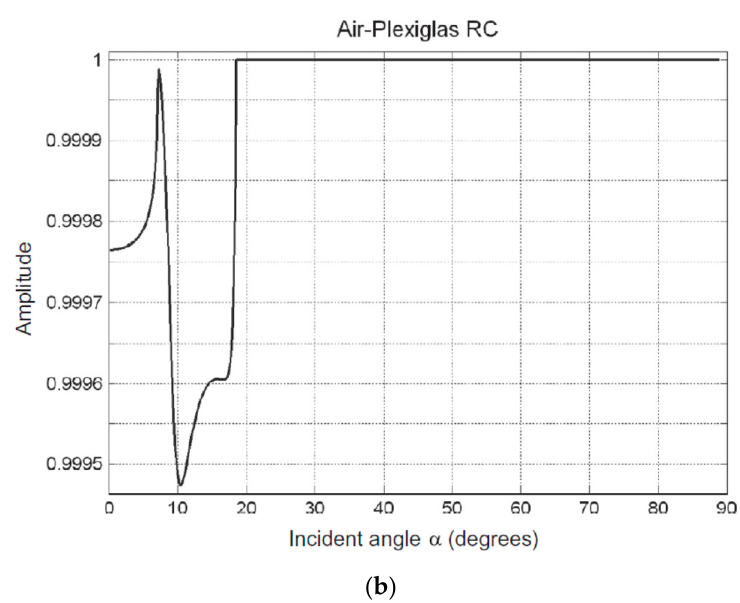
Figure 18. Reflection coefficient of an ( a ) air–aluminum interface and ( b ) air–plexiglass interface. Reprinted from [335], Copyright (2014), with permission from Elsevier.